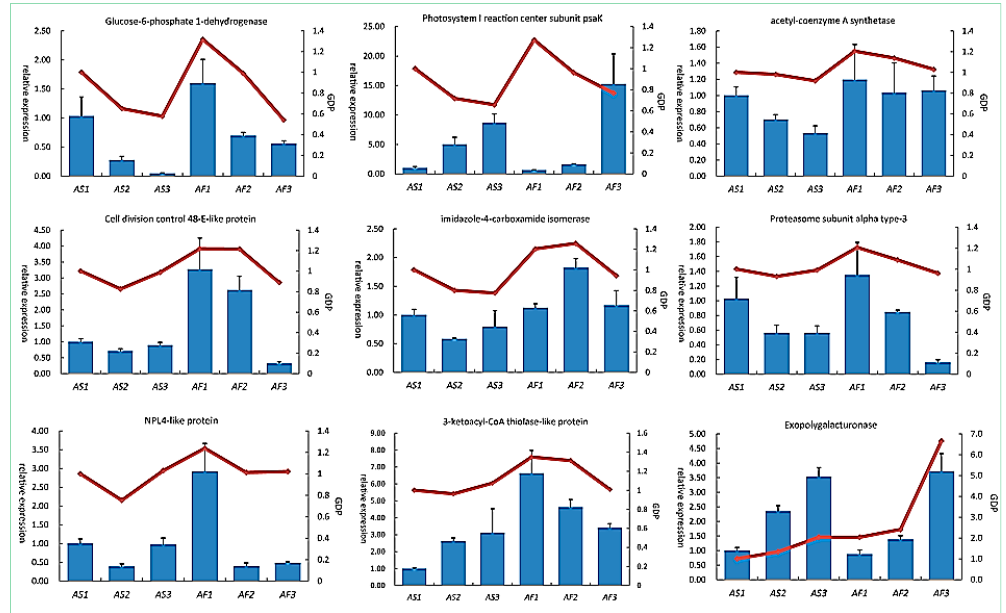
Figure 7. Expression levels of candidate DAPs according to qRT-PCR (histogram) and proteomics (line chart). qRT-PCR data represent the means based on three replicates and bars represent standard errors. GDP represents the level of expression of protein combined with proteomic data.